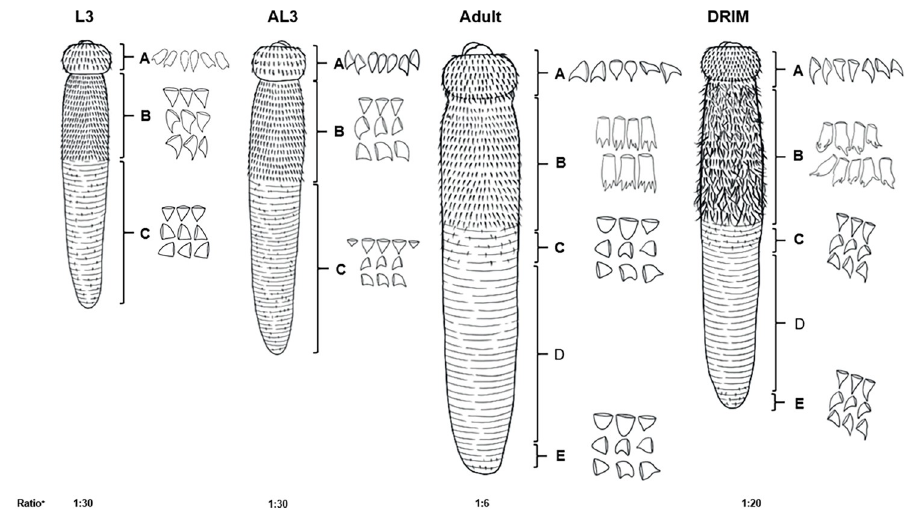
Fig 5. Diagram for various stages of G . spinigerum . Cephalic spines (A); Anterior body cuticular spines (B); Middle- Posterior body cuticular spines (C); Cuticular spine naked-areas (D); Caudal body cuticular spines (E). The ratio of real image: The ratio of magnification image ( +